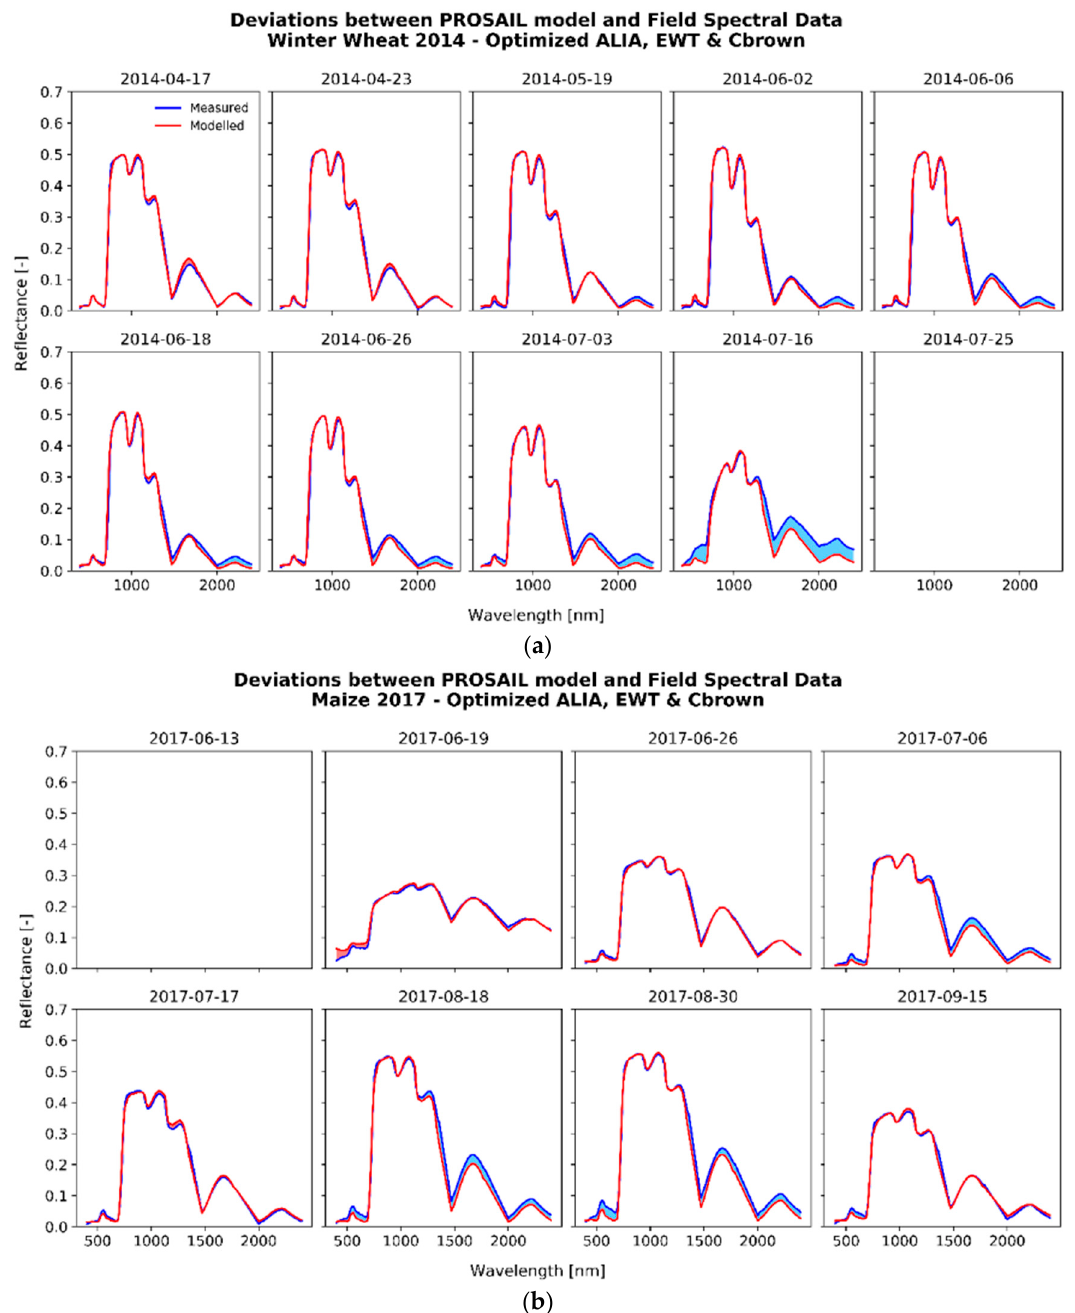
Figure 7. In the second step of the optimization, C brown was fitted in the red edge region. Examples demonstrate the final fitting results for winter wheat 2014 ( a ) and silage maize 2017 ( b ).